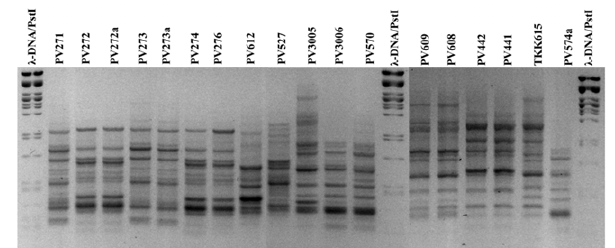
Figure 1. Agarose gel electrophoresis of BOX-PCR of 18 local P. viridiflava isolates. Agarose gel electrophoresis of BOX-PCR amplifi- cation products from genomic DNA of 18 local P. viridiflava isolates. The molecular size marker is l phage DNA digested with the restriction endonuclease Pst I. The negative film filter was applied to the image of an ethidium bromide gel. Isolate codes are given over each lane.